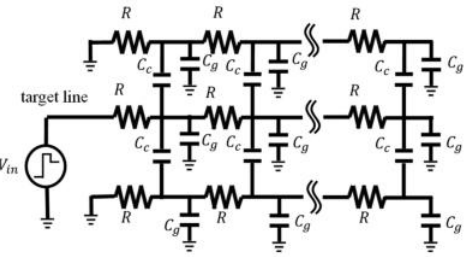
Figure 16. General three-line model with grounded cap Cg and coupling cap Cc.